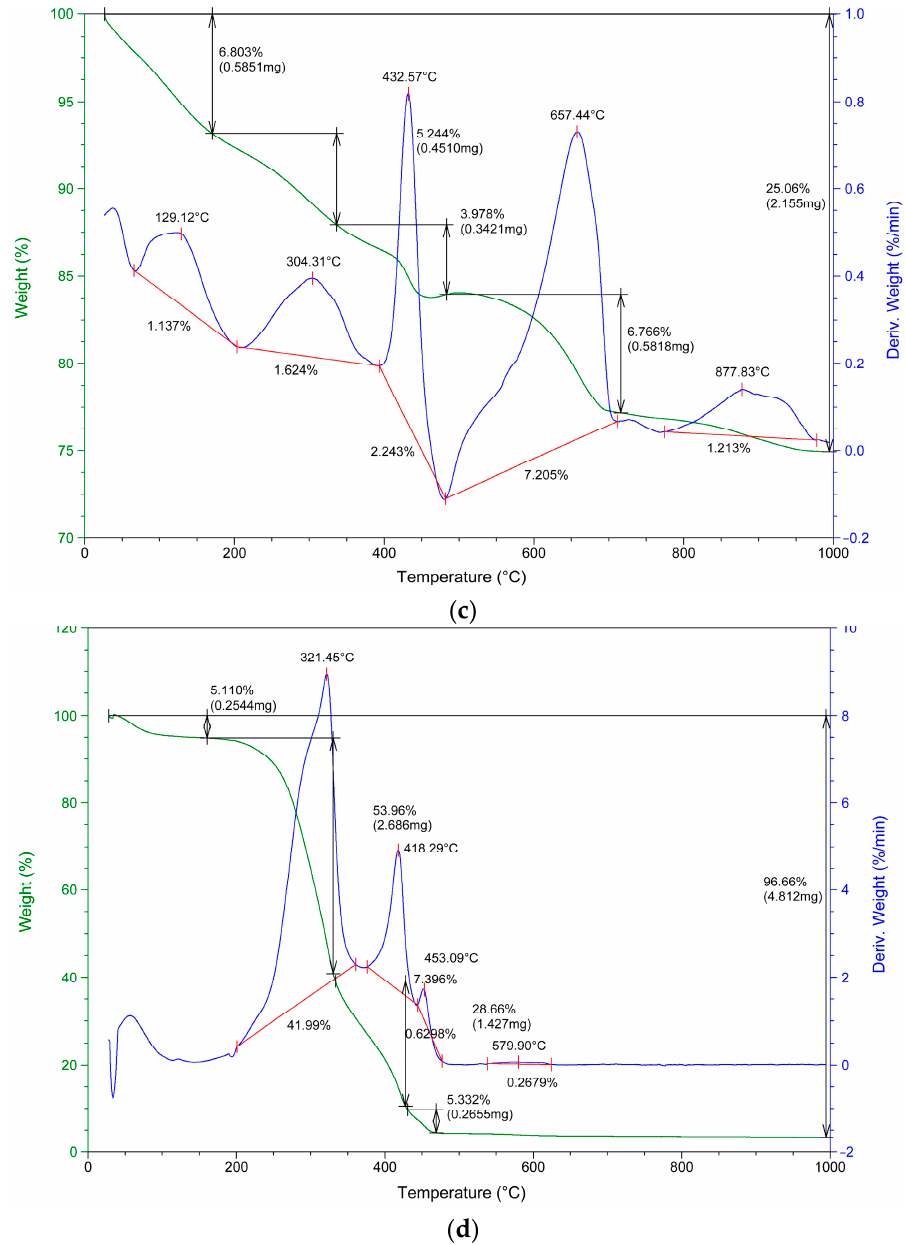
Figure 3. TGA curve of the ( a ) CEM, ( b ) CP, ( c ) CP10VSW and ( d ) VSW samples.